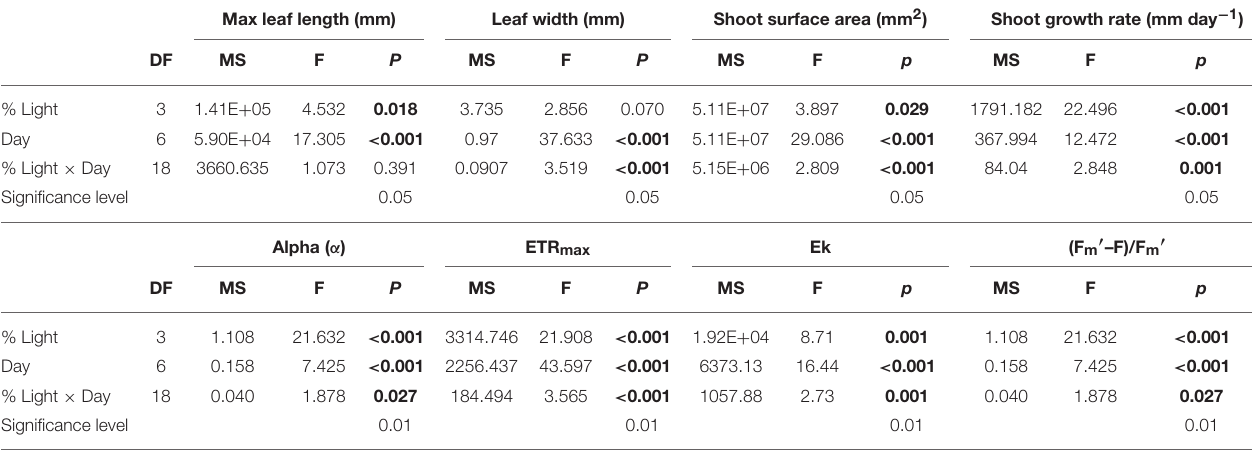
TABLE 2 | Results of two-way repeated measures ANOVA testing for the within-subjects effects of time and treatment on the morphological parameters maximum leaf length, width shoot surface area, and shoot growth rate, and on the photosynthetic parameters Alpha ( α ), ETR max and Maximal yield [(F m ′ –F)/F m ′ ]. Max leaf length